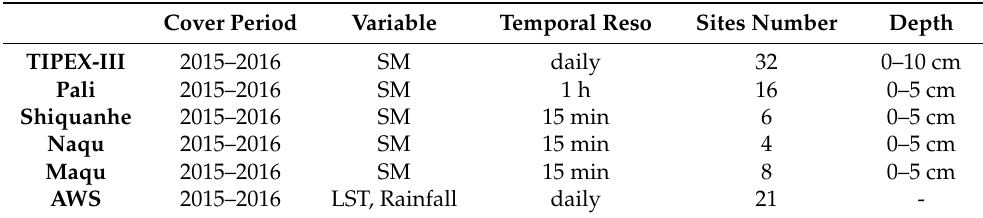
Table 1. Data sampling information of the in situ